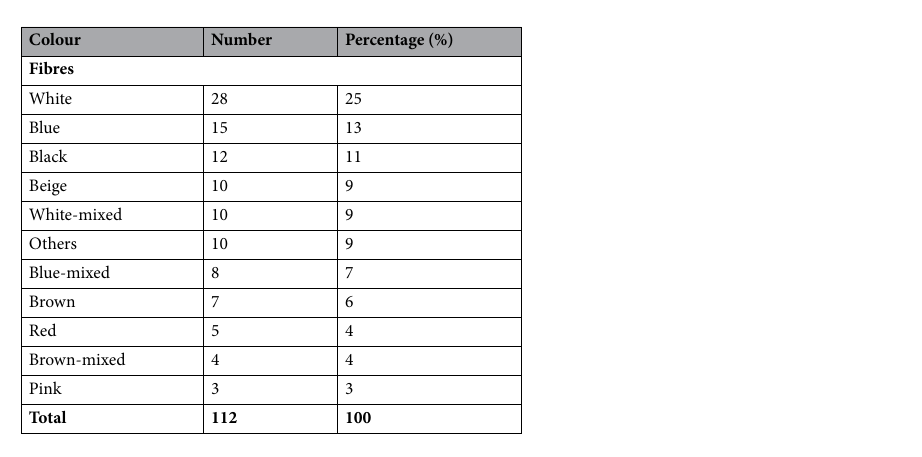
Table 4. Colours of marine microdebris in juvenile coral trout. Number and proportion of different coloured marine microdebris items (for fibres only), detected in the gastrointestinal tract of 20 juvenile coral trout ( Plectropomus leopardus and P. maculatus ) collected on reefs around four reef islands in the Great Barrier Reef World Heritage Area, Australia, in